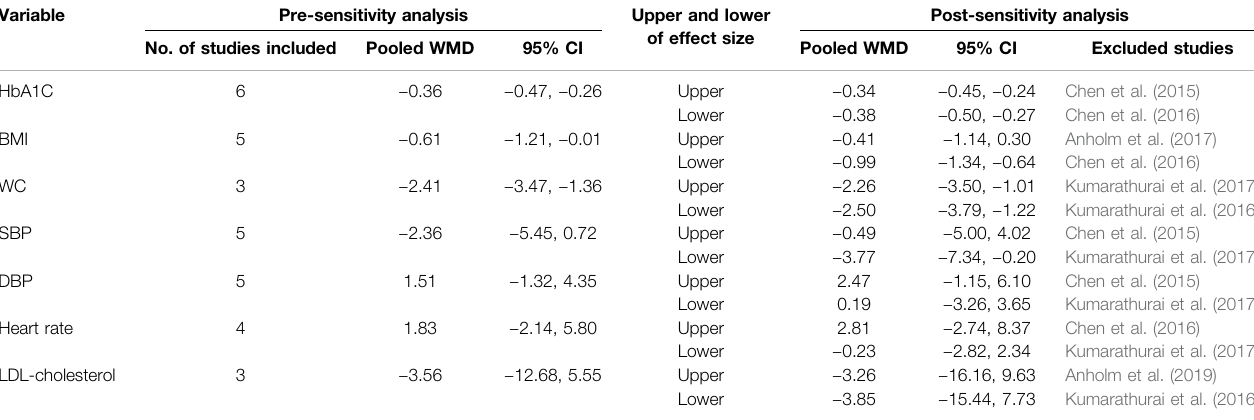
TABLE 2 | The effect of one by one trial in the association between liraglutide use and cardiometabolic pro fi les using sensitivity analysis.